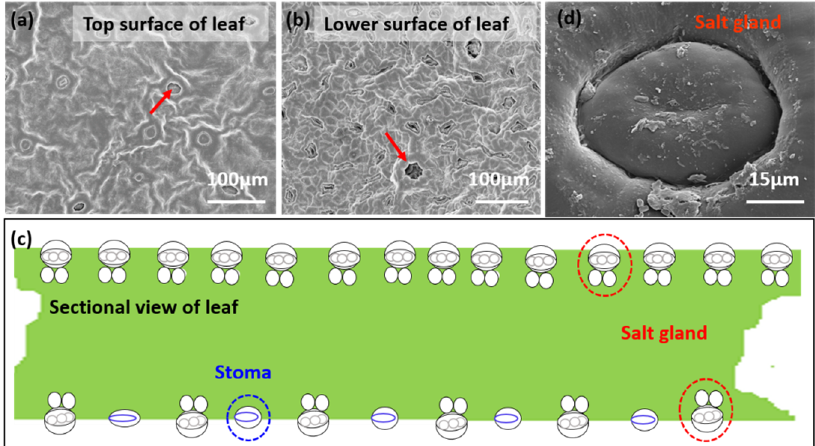
Figure 3. Salt glands distributed on the top and lower surfaces of mangrove leaves. ( a ) and ( b ) are morphologies of mangrove leaves on both surfaces. ( c ) Schematic illustration of the distribution of the salt glands on mangrove leaves. ( d ) SEM image of the salt gland on mangrove leaves.